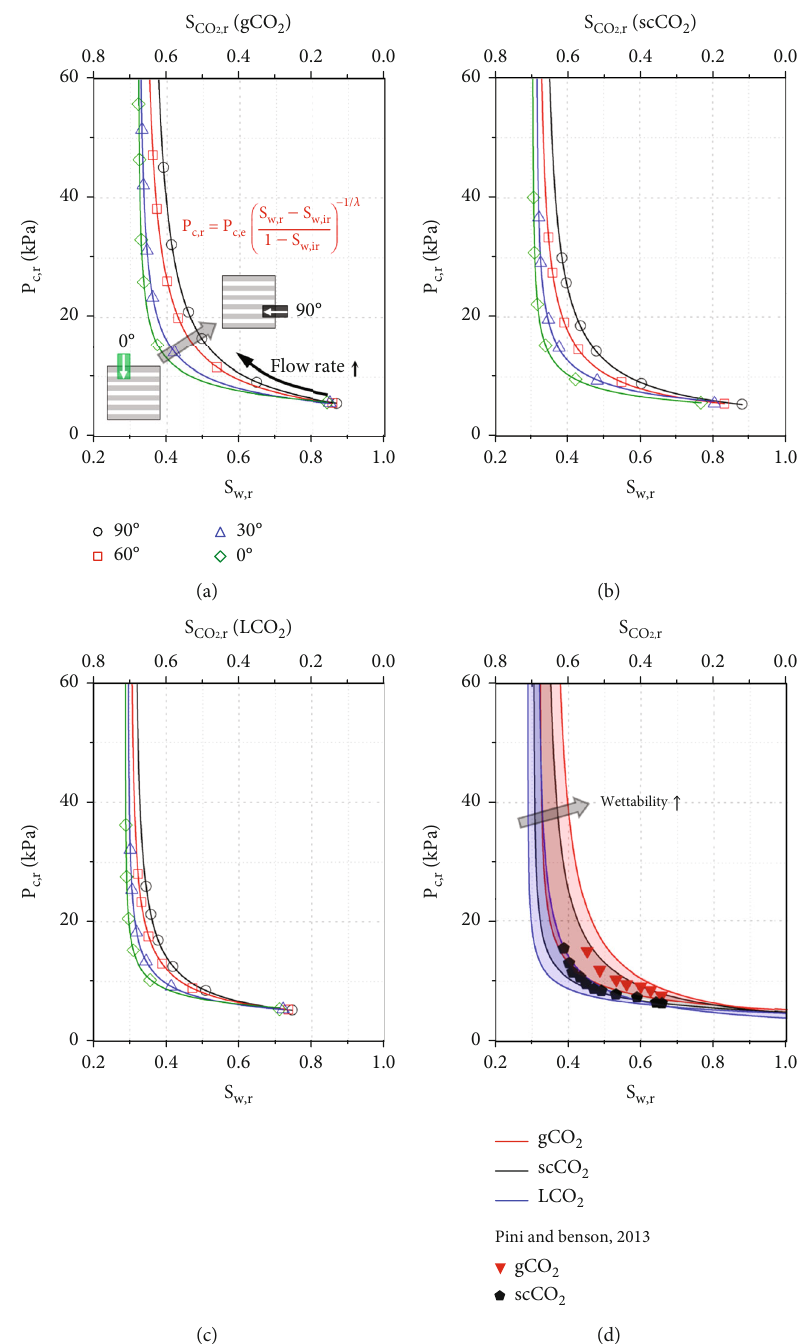
, (b) scCO , and (c) LCO . (d) Comparison with the 2 2 2